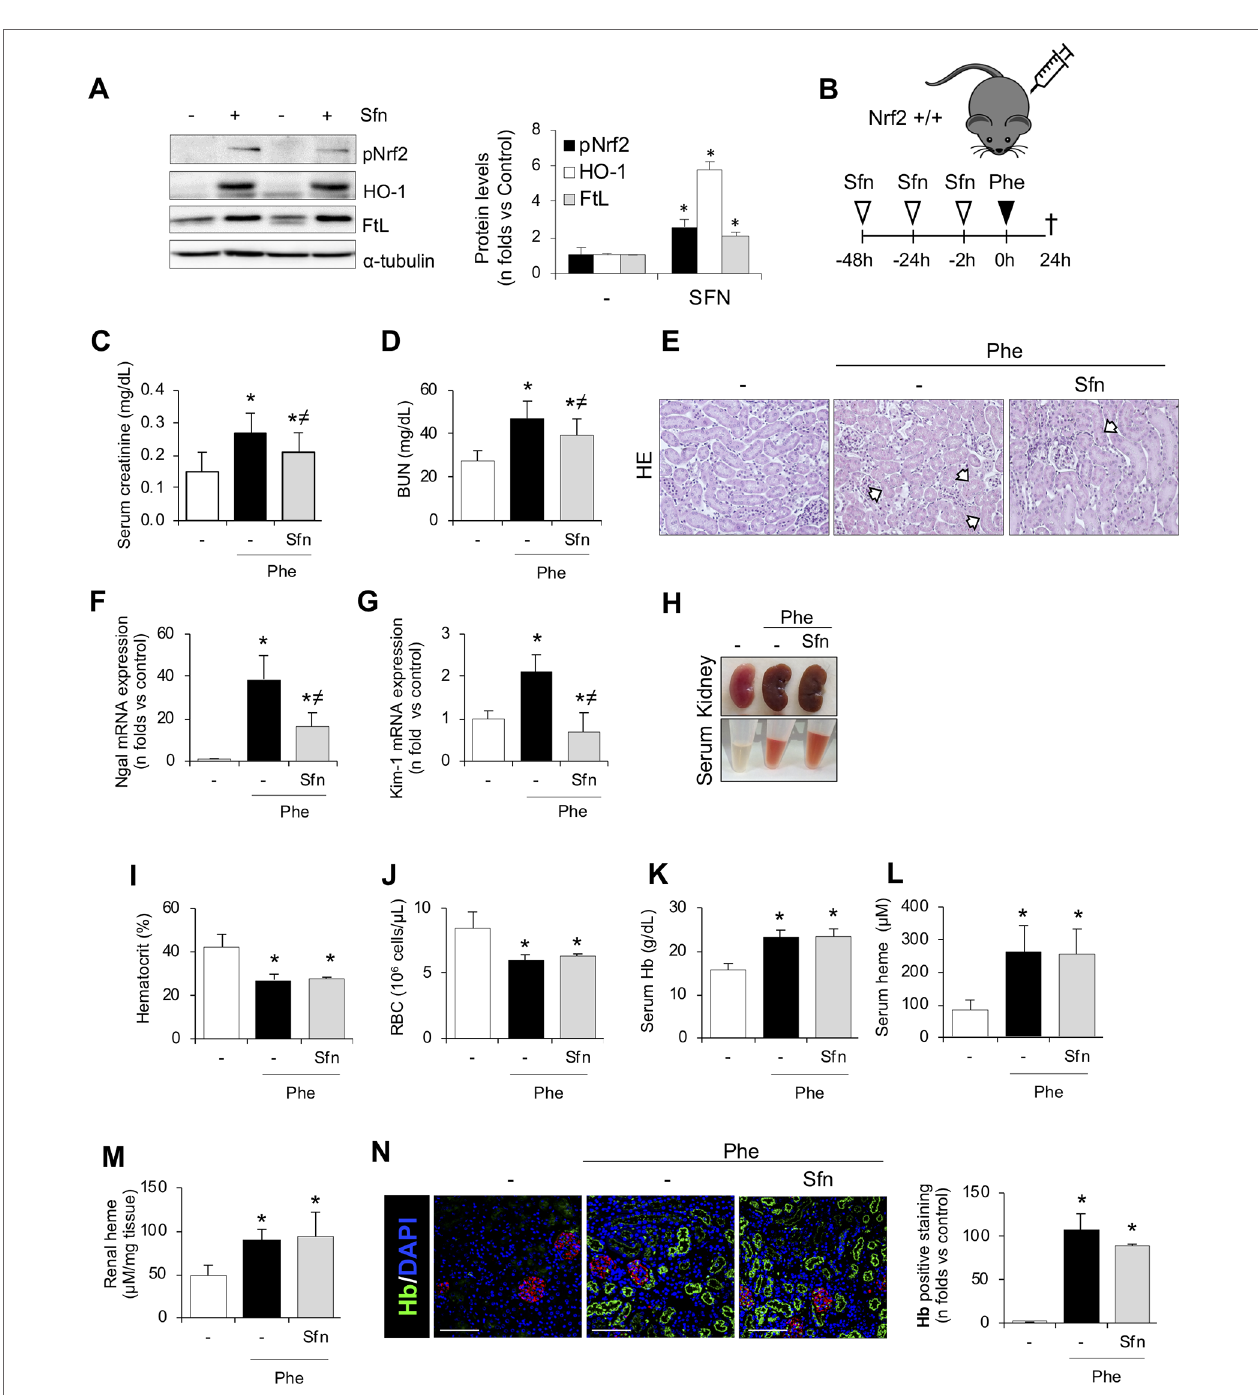
FIGURE 7 | SFN treatment ameliorates acute kidney injury and tubular damage induced by intravascular hemolysis. (A) C57BI/6 mice (males, 12 weeks old) were i.p. treated with saline or sulforaphane (SFN, 12.5 mg/kg) for 3 days ( n = 5/group). Representative western blot image showing phospho-Nrf2 (Ser40), HO-1, and FtL protein expression. (B) C57BI/6 mice (males, 12 weeks old) were i.p. treated with saline or sulforaphane (SFN, 12.5 mg/kg) for 48, 24, and 2 h before phenylhydrazine ( n = 5/group). Mice were sacrificed 24 h after phenylhydrazine administration. Schematic representation of intravascular hemolysis mouse model. Serum measurement of creatinine (C) and blood urea nitrogen (BUN) (D) . Representative images showing hematoxylin and eosin staining (E) . Expression of tubular injury biomarkers NGAL (F) and KIM-1 (G) , as determined by real-time RT-qPCR, in kidneys from mice with intravascular hemolysis. (H) Representatives images showing kidney and serum after intravascular hemolysis in mice treated with SFN. Hematocrit (I) and total red blood cell (RBC) counts (J) . Serum levels of Hb (K) and heme (L) . (M) Heme concentrations in renal tissue. (N) Representative images showing hemoglobin (Hb, green) accumulation obtained by confocal microscopy (left panel). The podocyte marker nephrin (red) was used to delimitate the glomerular area. Nuclei were stained with DAPI (blue); scale bar, 100 μm. Semi-quantification Hb-positive staining per cross section (right panel). Results are expressed as mean ± SEM. * p < 0.05 vs control mice, ≠ p < 0.05 vs Phe-injected